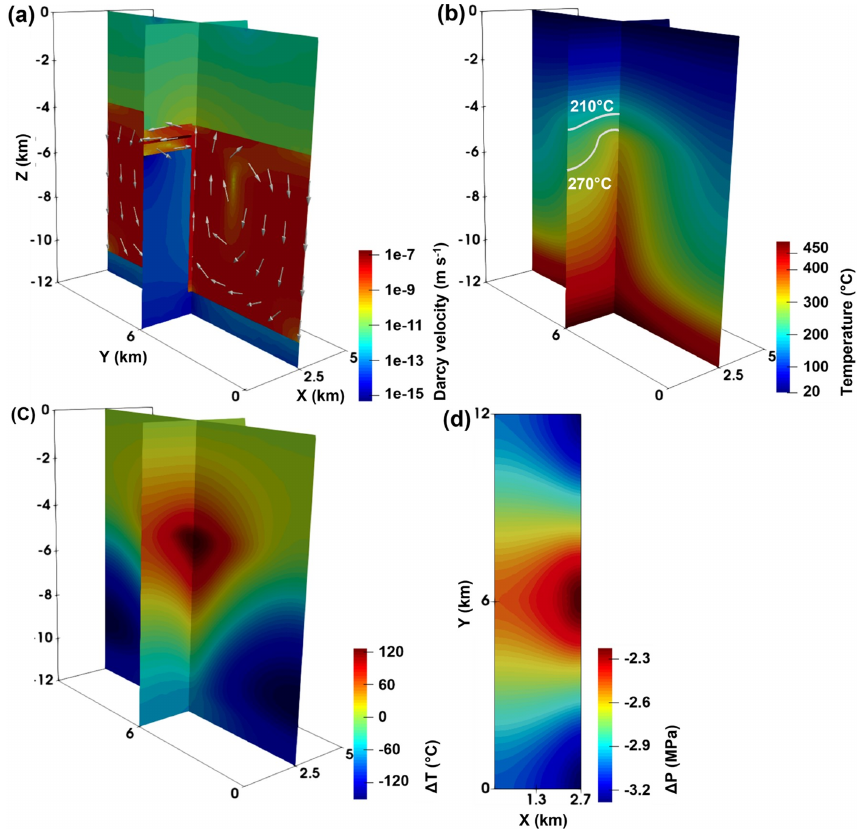
Figure 5. Fluid-flow, temperature and pore-pressure change fields of the κ MF = 10 − 15 m 2 case at 1Myr. Cross-sectional view of the (a) flow field with arrows representing the preferential fluid-flow pathways and (b) resulting temperature field. The 210 and 270 ◦ C are highlighted to indicate the dominant heat-transfer types. Panel (c) shows the temperature differences compared to the initial conductive temperature distribution. Panel (d) represents the top view of the pore-pressure change compared to the initial hydrostatic pore pressure (43.3MPa) in the western sandstone, transfer faults and main fault at a depth of 4.4km. The 1.3 and 2.7km along the x axis follow the western boundary of the Piesberg quarry and the eastern boundary of the main fault,